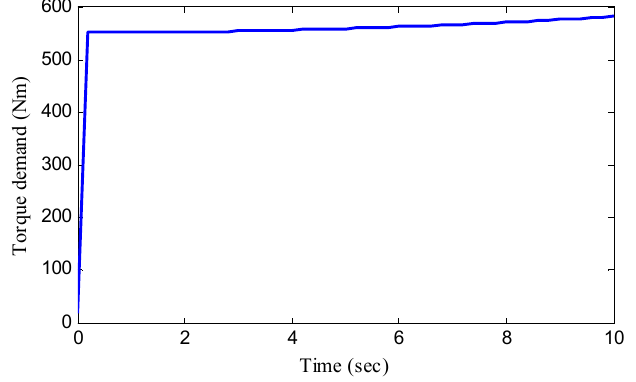
Figure 14. Torque demand in case study 2.